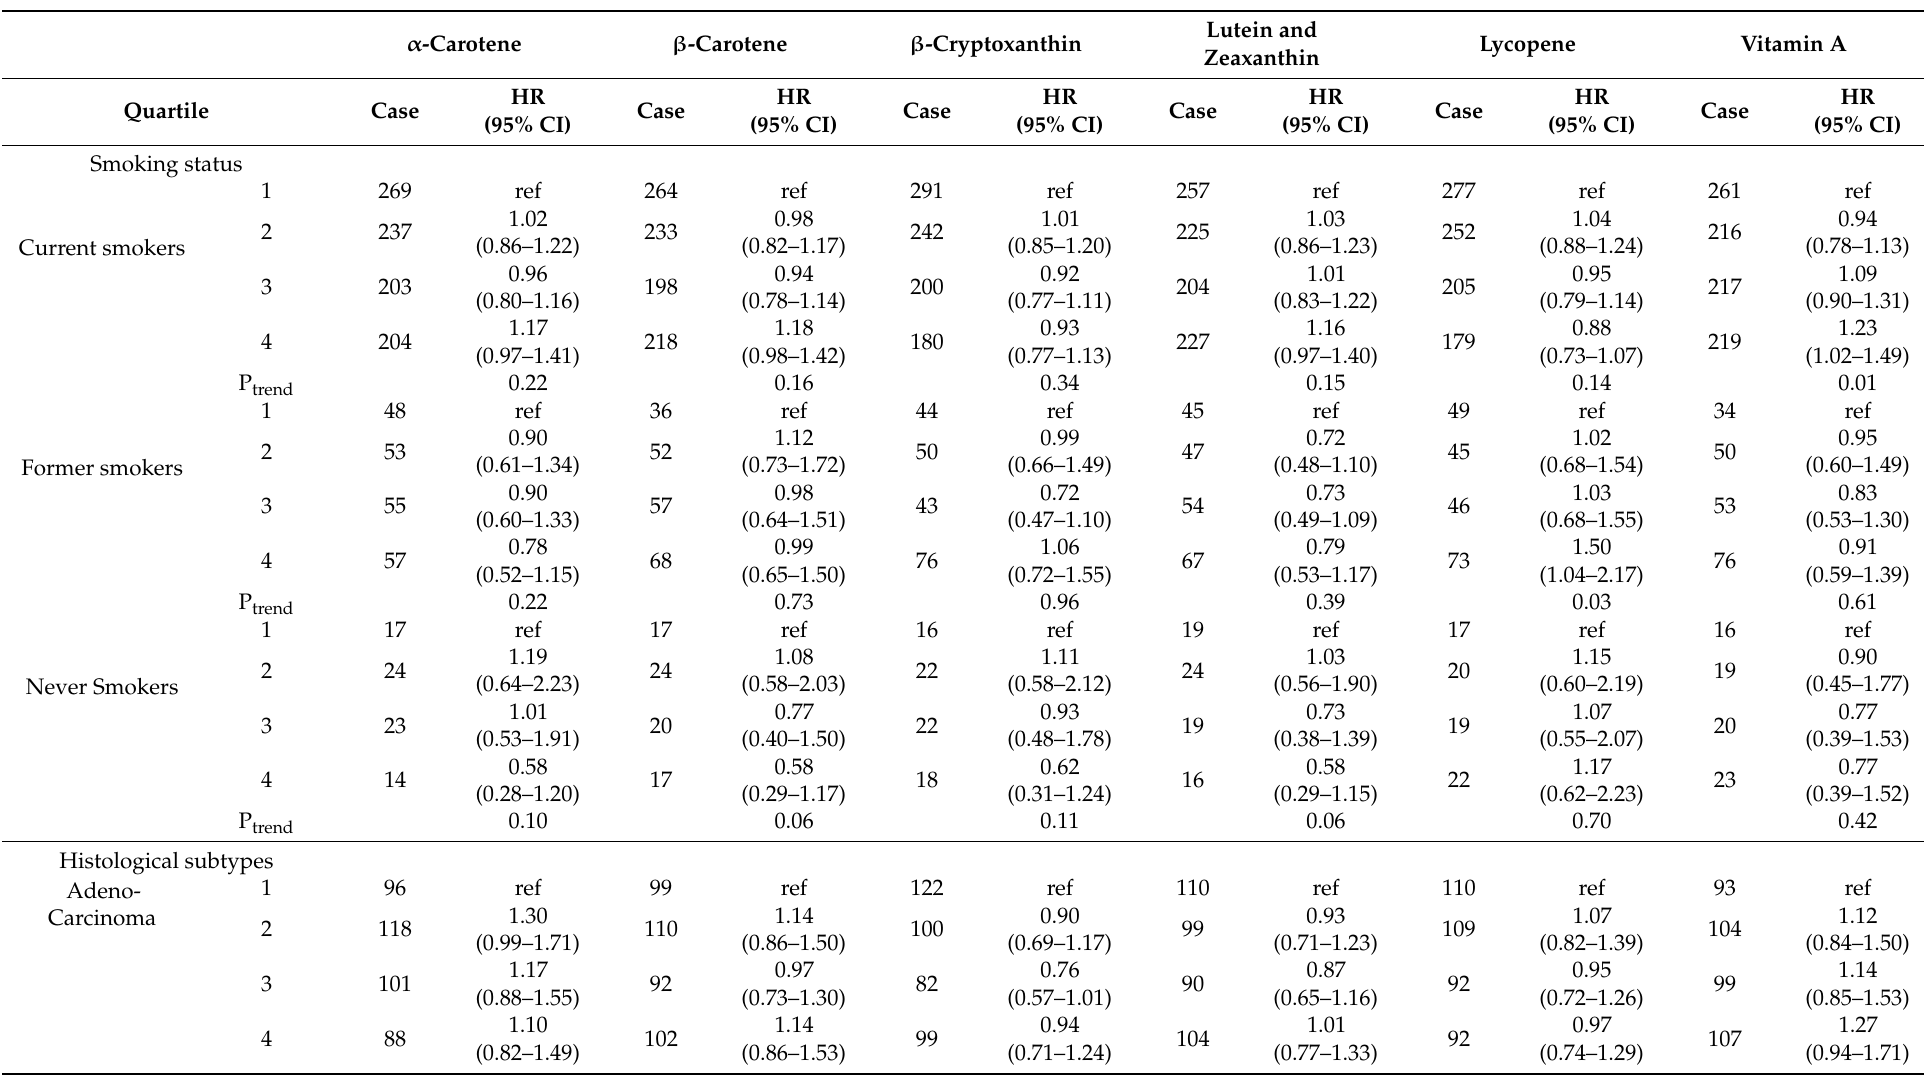
Table 4. Associations of dietary intakes of carotenoids and vitamin A with lung cancer risk by smoking status and lung cancer histological subtypes, SCCS. α -Carotene β -Carotene β -Cryptoxanthin